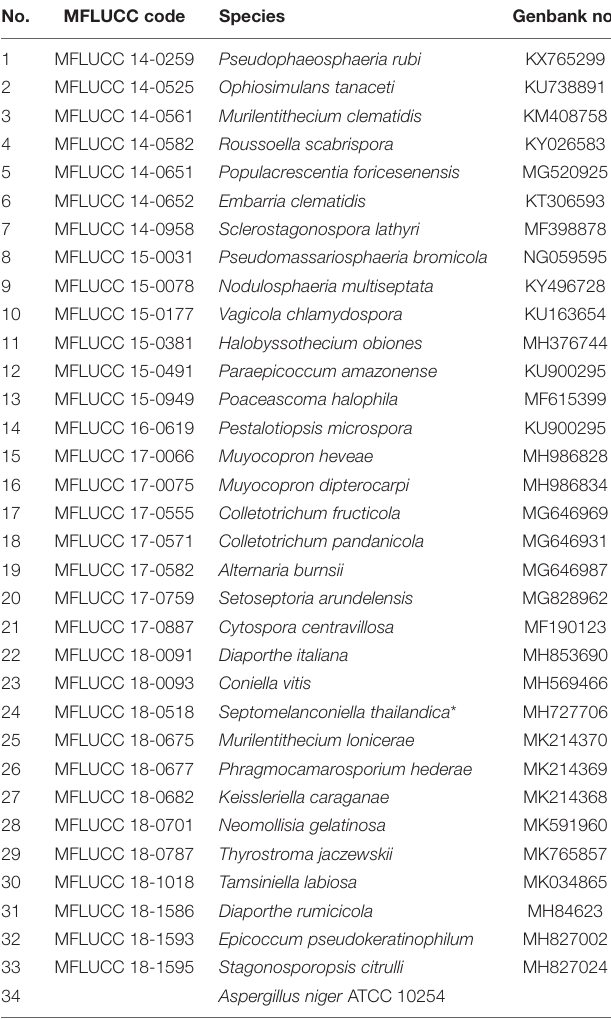
TABLE 1 | List of fungi for screening of PUR